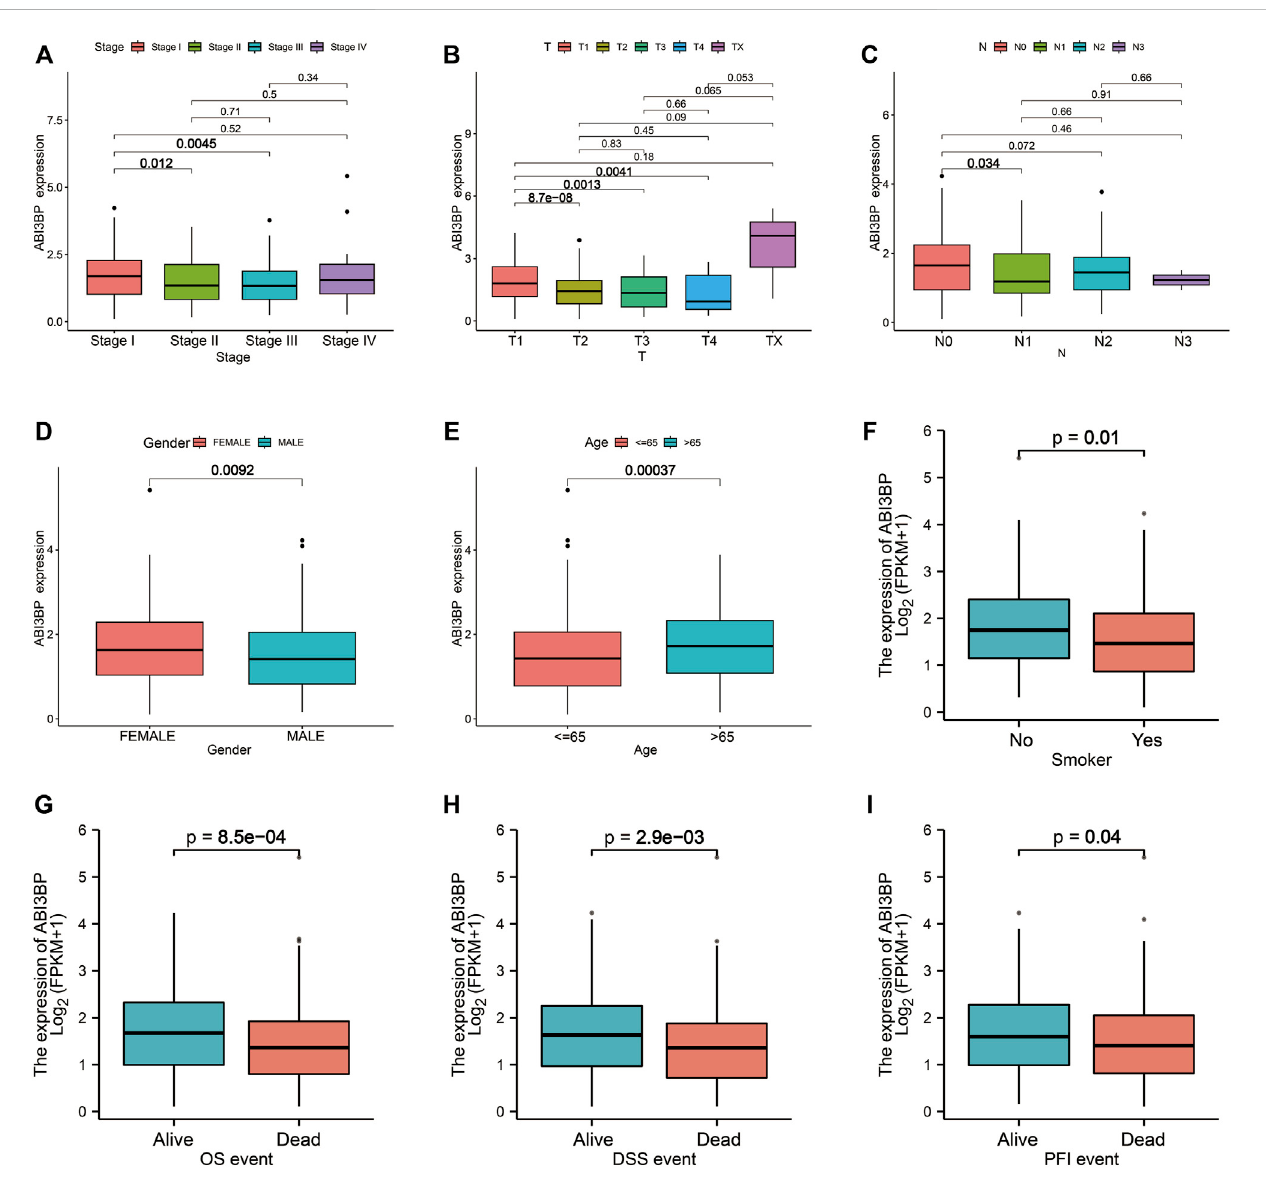
FIGURE 3 TherelationofABI3BPandclinicalfeaturesofpatientswithlungtumor.TherelationshipbetweenmRNAexpressionlevelsofABI3BPandthestages (A) ,T stages (B) , N stages (C) , sex (D) , age (E) , smoking history (F) , OS events (G) , DSS events (H) , and PFS events (I) . *, p < 0.05 **, p < 0.01 ***, p <